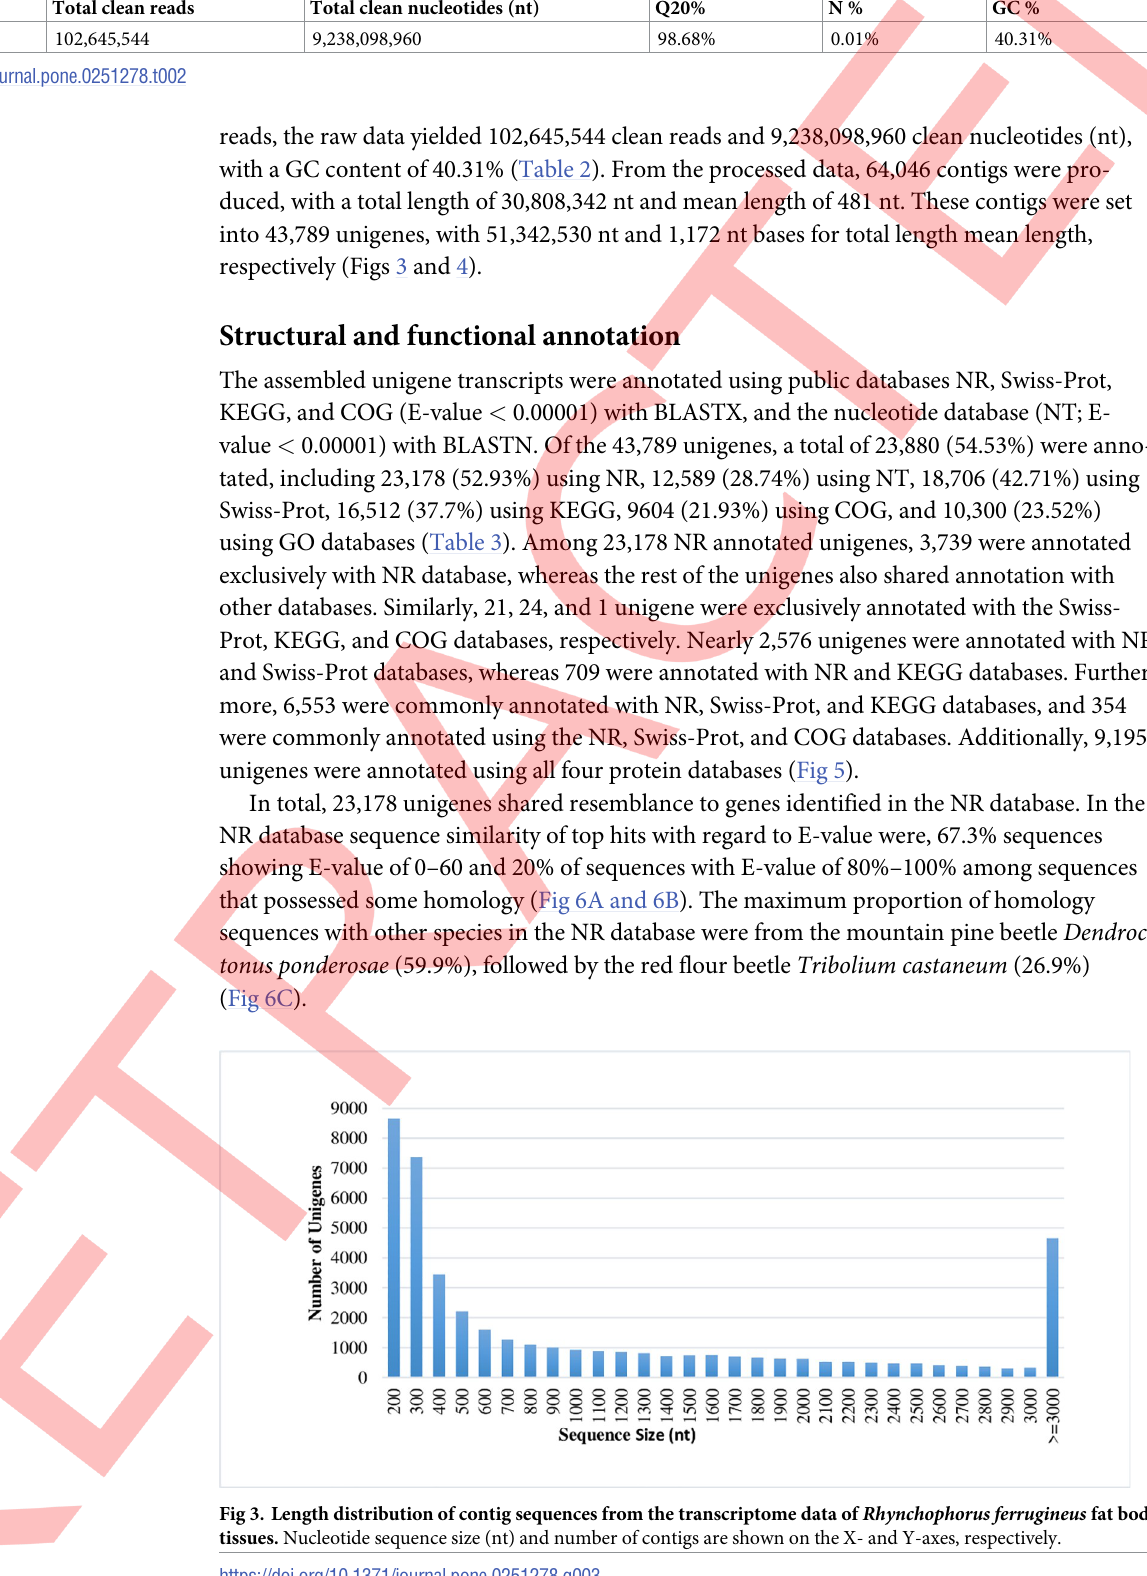
PLOS ONE | https://doi.org/10.1371/journal.pone.0251278 May 24,